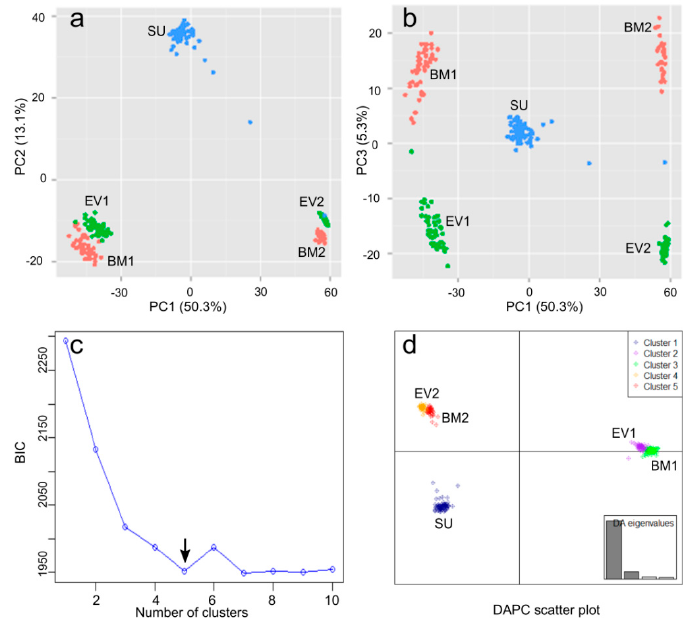
Figure 3. Principal component analysis (PCA) and discriminant analysis of principal components (DAPC) of the 260 individuals in three bi-parental populations (BM, EV and SU) based on 17,288 SNPs. ( a ) Bi-plot of the first and second principal components (PCs); ( b ) Bi-plot of the first and third PCs; ( c ) k -means clustering analysis based on 100 chosen PCs shows that the optimal number of clusters ( k ) is 5, that is where the Bayesian information criterion (BIC) is lowest (arrow); ( d ) DAPC scatter plot. Percentages in parentheses in the axis titles of ( a ) and ( b ) represent the variance explained by the respective PCs. Individuals from the BM and EV populations grouped into two subpopulations each, BM1 and BM2, and EV1 and EV2, respectively.